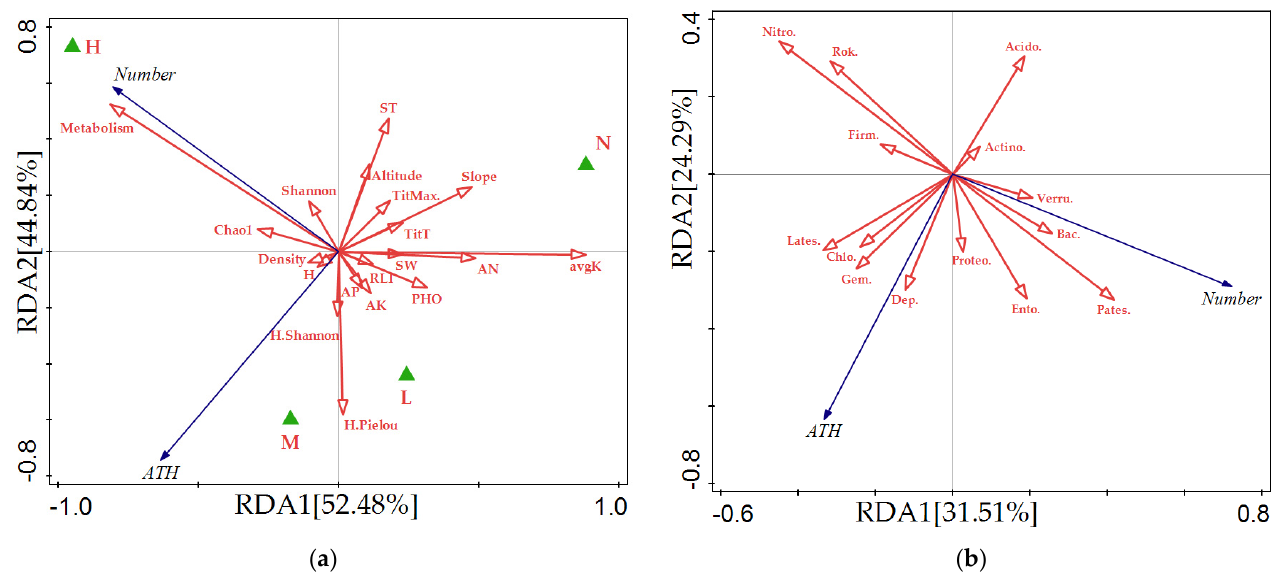
Figure 5. An ordination diagram of the results of the RDA analysis between diversity, composition and network structure of soil bacterial communities, stand structure, soil nutrients, litter, topographic variables and stand regeneration. ( a ) The relationship between number, height, and impact factors; ( b ) The relationship between number, height, and relative abundance of soil bacteria at phyla level. Note: In the figure, each point represents a grouping. The red arrows represent different influencing factors. The sharp angle indicates that two factors are positively correlated, the right angle is not correlated, and the obtuse angle is negatively correlated. The smaller the angle, the higher the correlation. The percentages in the brackets of the coordinate axes represent the proportion of variation in the raw data that can be explained by the corresponding axes. Abbreviations of soil bacterial communities at phyla level are as follows: Proteo., Proteobacteria; Actino., Actinobacteria; Acido., Acidobacteria; Chlo., Chloroflexi; Rok., Rokubacteria; Gem., Gemmatimonadetes;